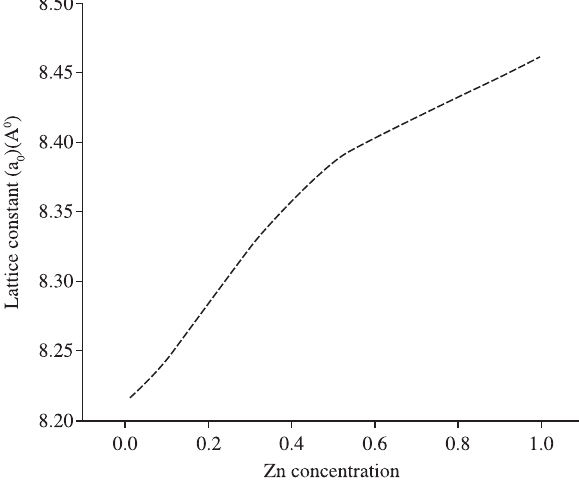
) (Å) with Zn concentration for 0